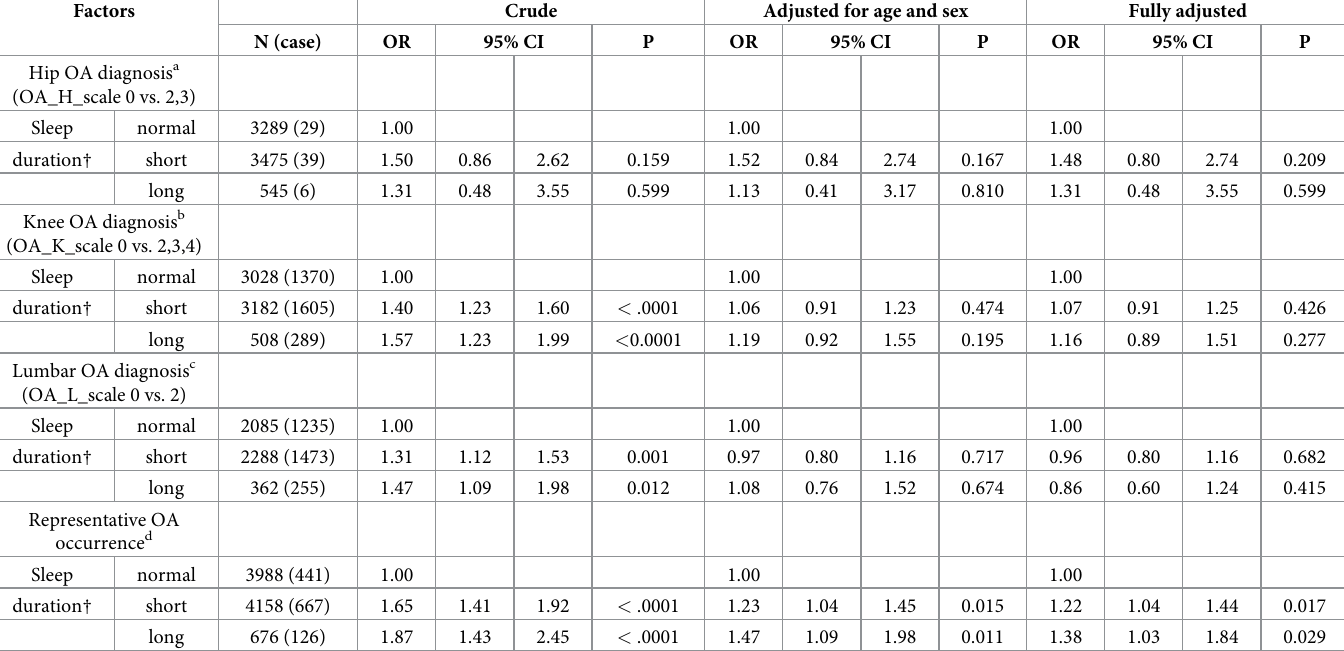
Table 4. Relationship between sleep duration and radiological OA